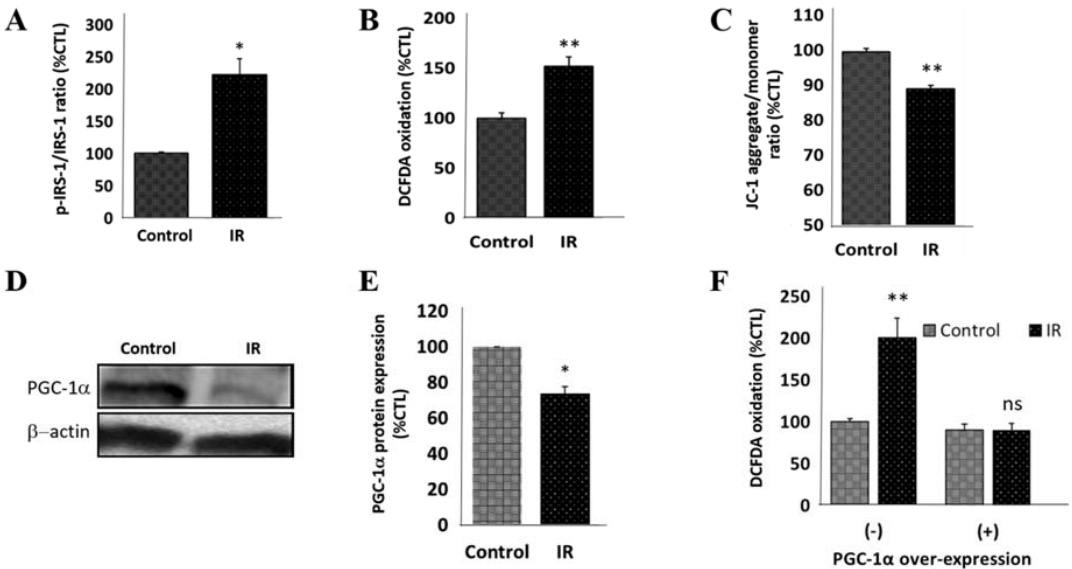
Figure 4. Peroxisome proliferator ‐ activated receptor gamma coactivator 1 ‐ alpha impedes IR ‐ induced mitochondrial dysfunction. Graphs of the differential ( A ) p ‐ IRS ‐ 1/IRS ‐ 1 ratio (control: 100 ± 1.7%, IR: 223 ± 25%, p < 0.05, n = 4), ( B ) DCFDA (2 ′ ,7 ′‐ dichlorodihydrofluorescein diacetate) oxidation (control: 100 ± 5.3%, IR: 152.1 ± 8.9%, p < 0.01, n = 4), and ( C ) JC ‐ 1 aggregate/monomer ratio (control: 100 ± 1.5%, Representative Western blot images and ( E ) densitometry ‐ based histograms showing differential proliferator ‐ activated receptor gamma coactivator 1 ‐ alpha (PGC ‐ 1 α ) protein expression in IR and non ‐ IR control SH ‐ SY5Y cells (control: 100 ± 0%, IR: 73.4 ± 4.1%, p < 0.05, n = 4). β‐ actin is the loading